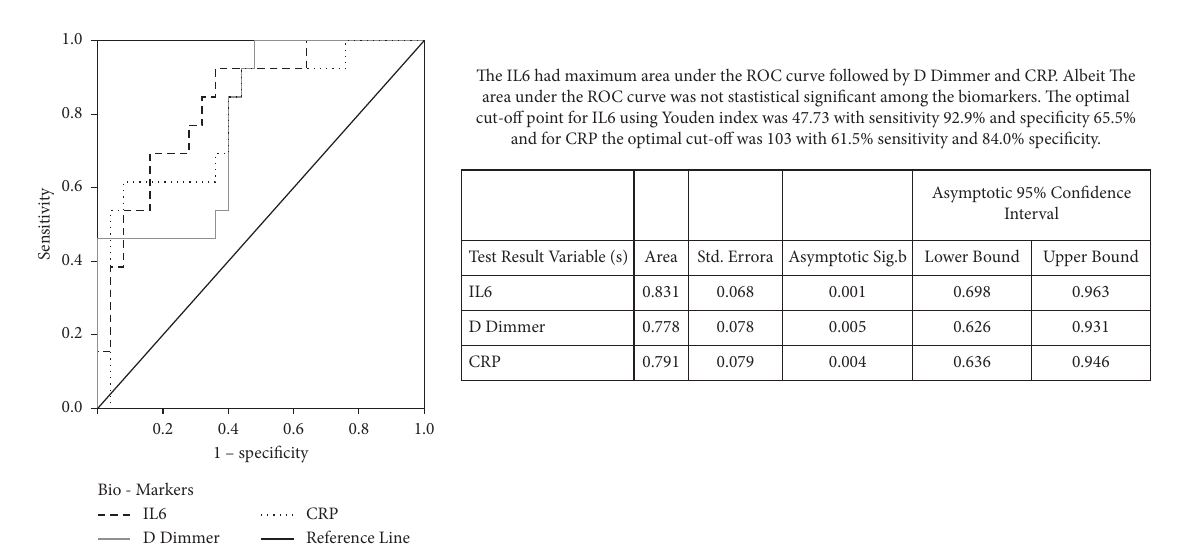
Figure 2: ROC curve for diomarkers IL-6, D-dimer, and CRP in kidney transplant recipients with COVID-19.